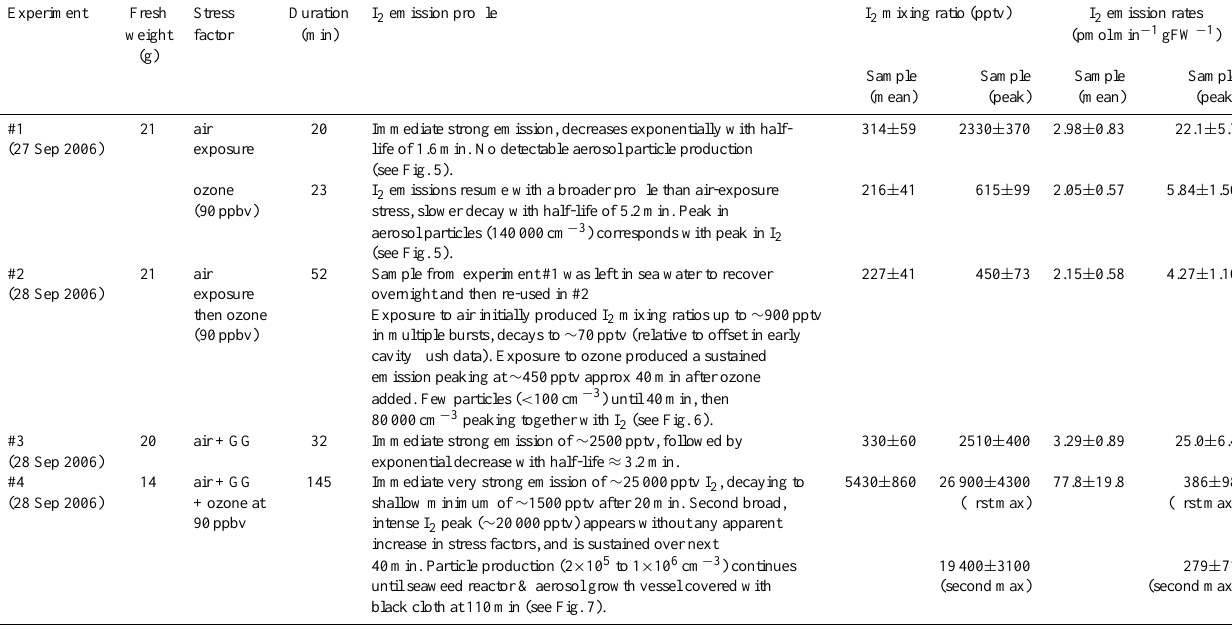
Table 2. Iodine mixing ratios, emission profiles and emission rates observed during the Laminaria digitata stress factor experiments.